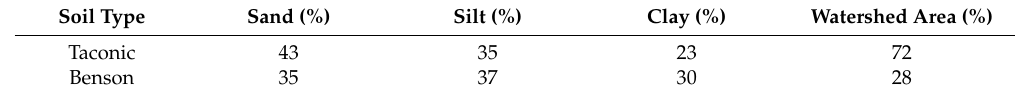
Table 2. The soil types in the Mahabad Dam watershed.